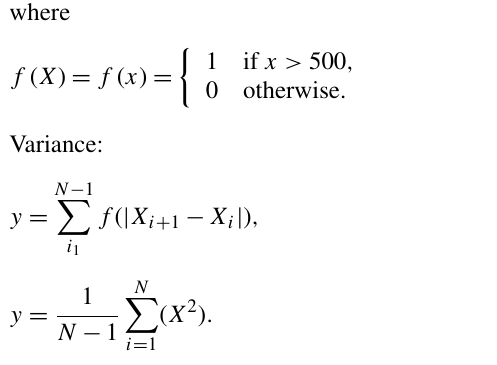
Figure 7. Myoware muscle